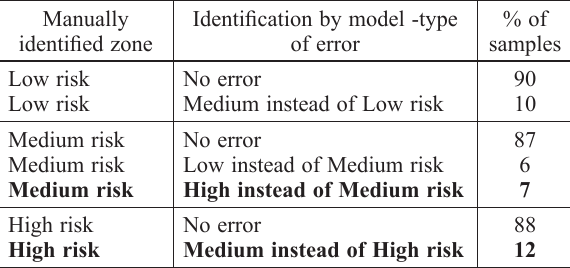
Table 3. Comparison of the method’s output with manually collected